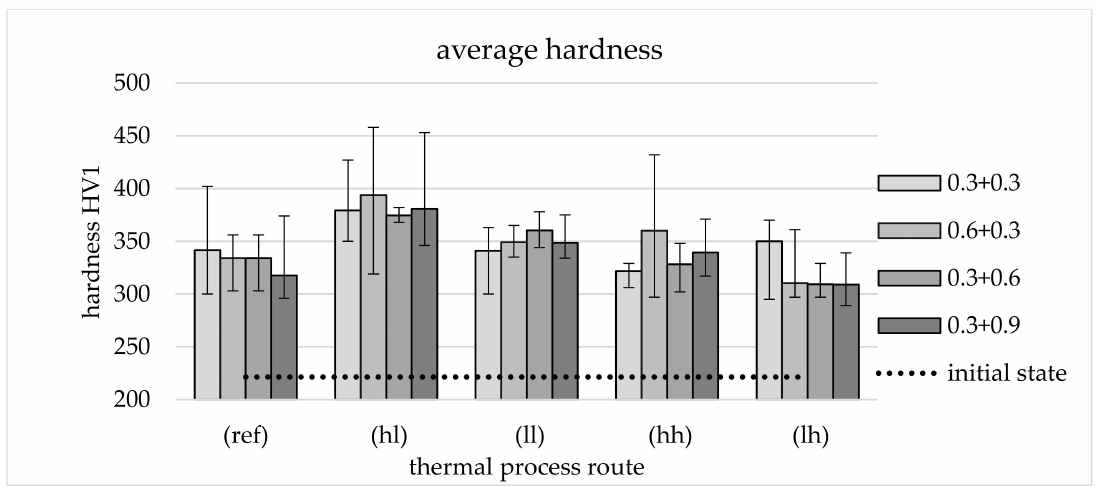
Figure 6. Hardness HV1: initial state, reference and di ff erent TMT routes with range of values.